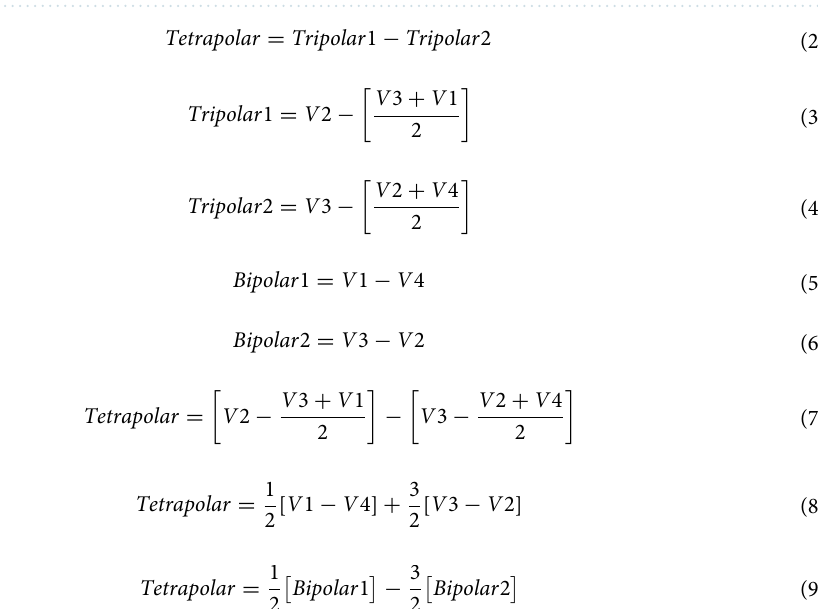
Figure 10. Process of extracting ENG signal. ( A ) An example of thresholding applied to raw ENG data, where the dashed lines represent ± 3δ deviation from the mean assuming purely uncorrelated additive white Gaussian noise sources (absolute value = 2.8 ± 0.3 µV). ( B ) Zoomed image of a single action potential that was recorded from the distal nerve stump (i.e., afferent) using a tetrapolar cuff electrode. ( C ) Steps applied to all raw data leading to feature extraction. The threshold in ‘Noise Thresholding’ block is constructed using a global representation of the noise, which was recorded from ENG channels with completely transected vagus nerve (e.g., absence of neural signal) and averaged across all experiments. The first three blocks (e.g., ‘Artifact Thresholding’, ‘Frequency Filtering’, and ‘Construct ENG Waveforms’) were applied to signal as well as the noise that is used for the thresholding